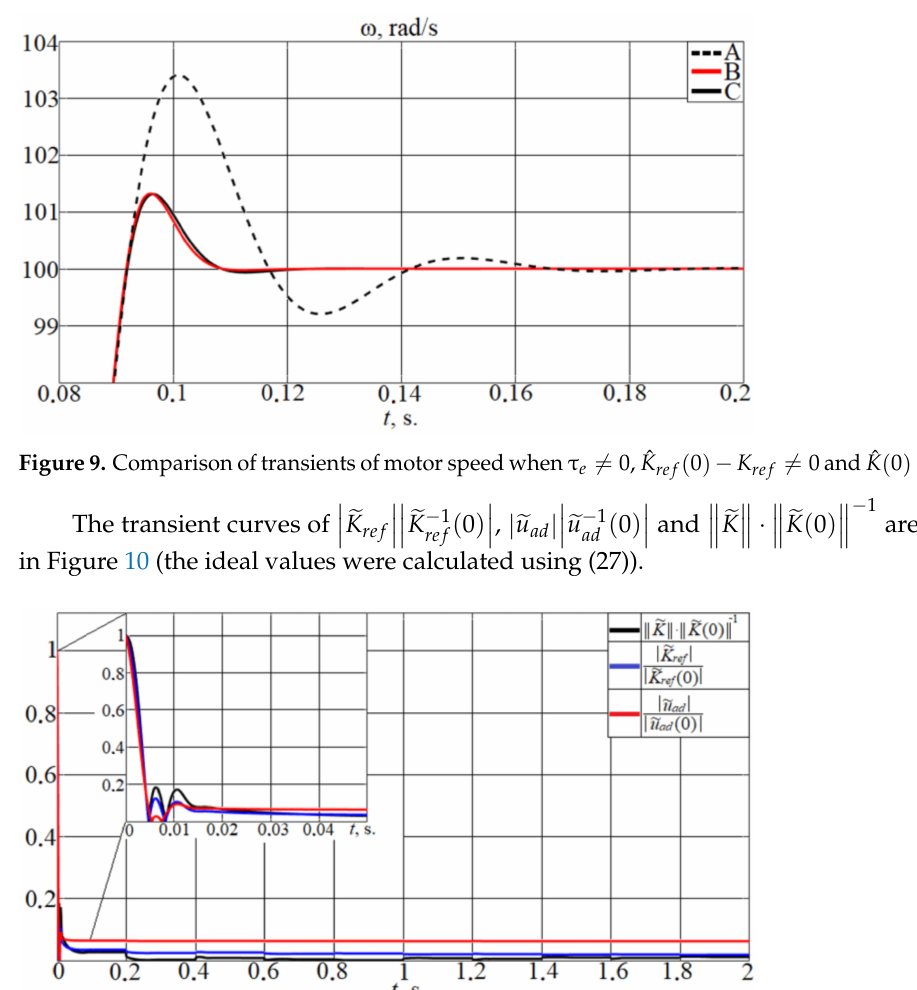
Figure 10. Comparison of transients of normalized